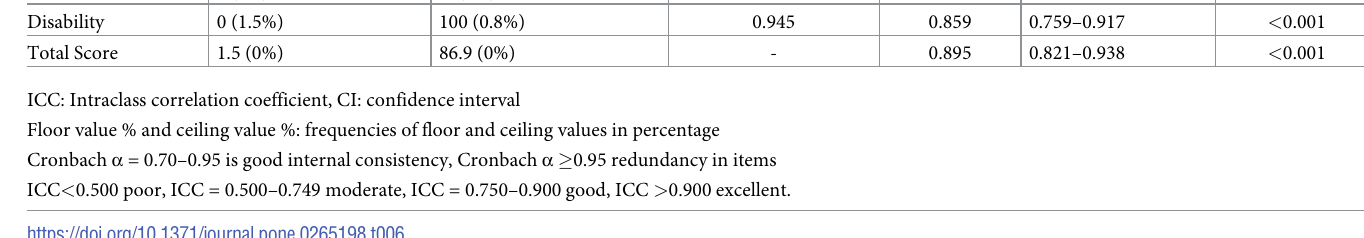
Table 6. Floor and ceiling values, internal consistency, and test-retest reliability of M-SPADI. M-SPADI Min (Floor